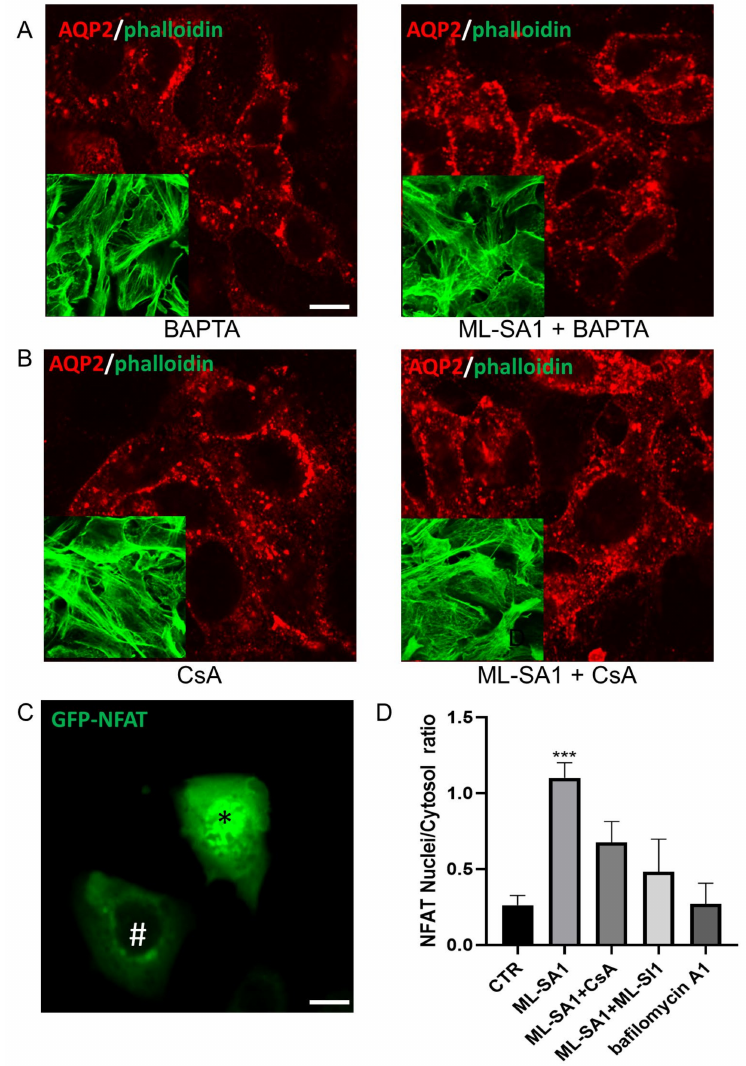
Figure 9. Ca 2+ /calcineurin pathway activation is involved in ML-SA1-induced AQP2 apical mem- brane accumulation in MCD4 cells. ( A ) Cells were treated for 30 min with 20 µ M BAPTA alone or followed by 100 µ M ML-SA1 for 15 min and stained with an antibody against AQP2 (red) and phal- loidin Alexafluor-488 to visualize F-actin (green, inset). Images are representative of 3 independent experiments; ( B ) Cells were treated for 30 min with 1 µ M CsA alone or followed by 100 µ M ML-SA1 for 15 min and stained with an antibody against AQP2 (red) and phalloidin Alexafluor-488 to visual- ize F-actin (green, inset). Images are representative of 3 independent experiments; ( C ) Representative image of M1 cells expressing NFATc4-GFP either in the cytosol (*) or in the nucleus (#). Scale bar: 20 µ m; ( D ) Histogram summarizing the ratio between the number of cells expressing NFATc4-GFP in the nucleus vs. cells expressing the probe in the cytosol. Cells were either left untreated (CTR) or stimulated as follows: 100 µ M ML-SA1 for 2 h alone or after 30 min pretreatment with either 1 µ M CsA or 25 µ M ML-SI1;100 nM bafilomycin A1 for 2 h. Data were obtained from 3 independent experiments. Five different fields for each treatment were blindly acquired and analyzed for every independent experiment. The number of cells analyzed for each treatment is as follows: CTR, n = 126 cells, ML-SA1, n = 93 cells, ML-SA1 + CsA, n = 111 cells, ML-SA1 + ML-SI1, n = 117 cells, bafilomycin A1, n = 129 cells. The graph shows mean ± SEM and significant differences were calculated by ordinary one-way ANOVA and Dunnett’s multiple comparisons test. *** p =